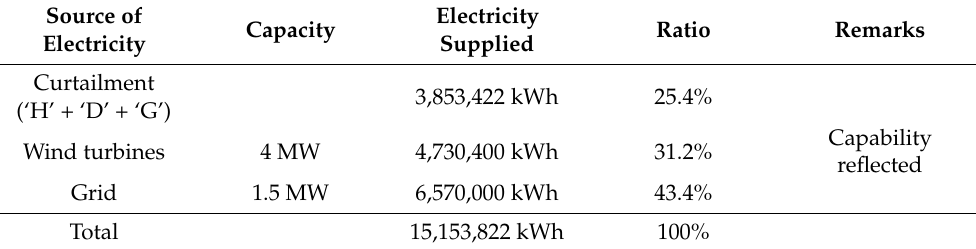
Table 32. The annual amount of electricity to be supplied to water electrolysis (Scenario